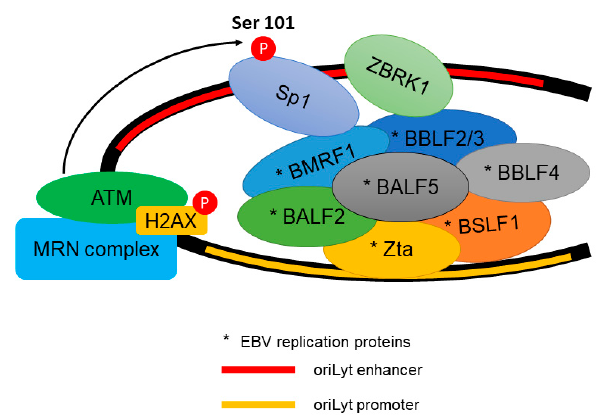
Figure 3. The recruitment of EBV (Epstein–Barr virus) lytic replication proteins to the oriLyt of the EBV genome. ATM phosphorylates Transcription factor Sp1 (Sp1) at Serine 101 residue. The phosphorylated Sp1 tethers and stabilizes other replication proteins which promote viral DNA replication.